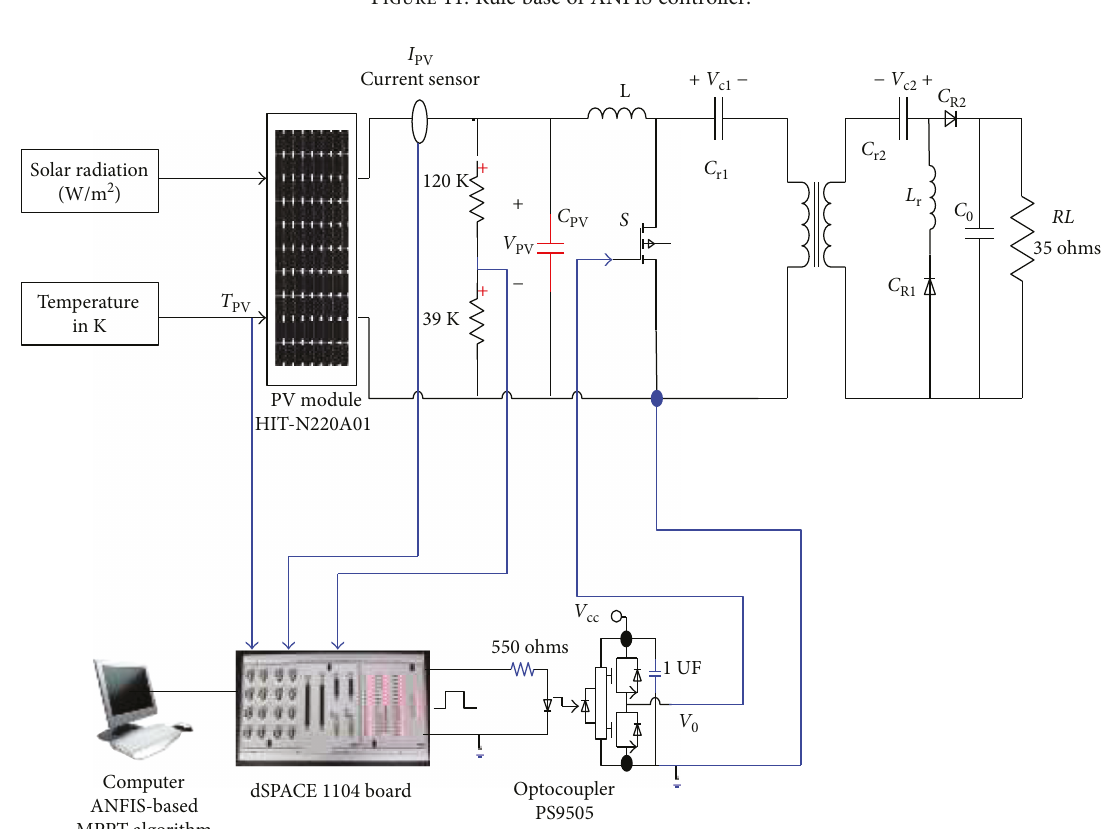
Figure 12: Schematic diagram of the hardware